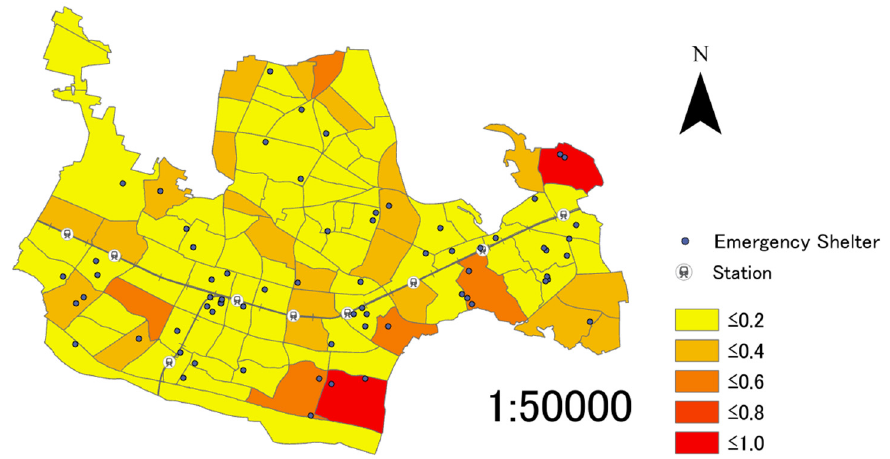
Figure 4. Result for Chofu City with the ratio of elderly population as a weighted coefficient.